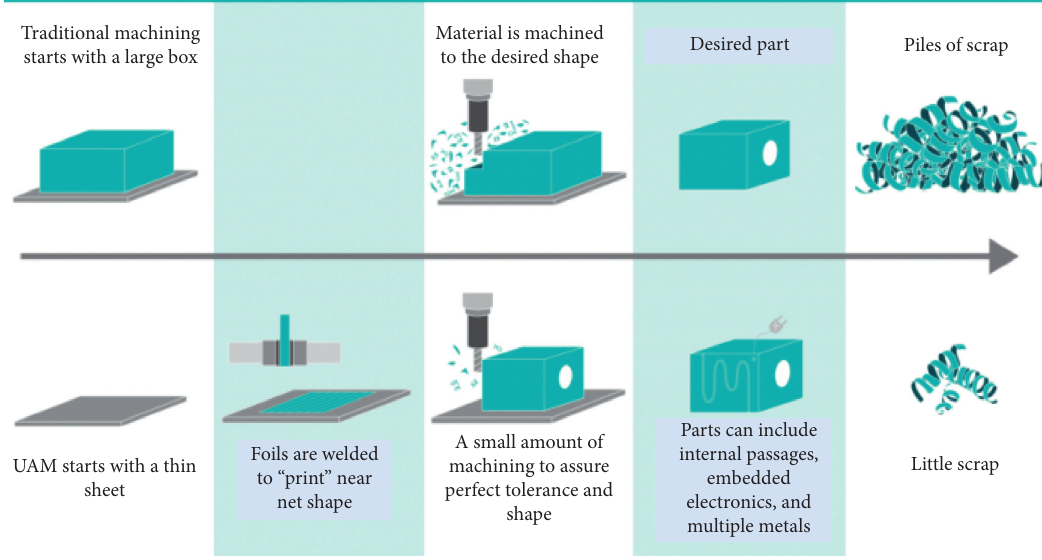
Figure 3: Difference between conventional CNC and UAM processes